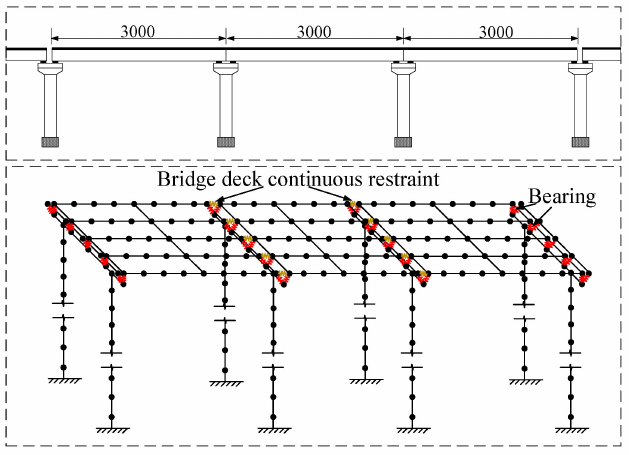
Figure 12. Bridge prototype layout and Finite element model.